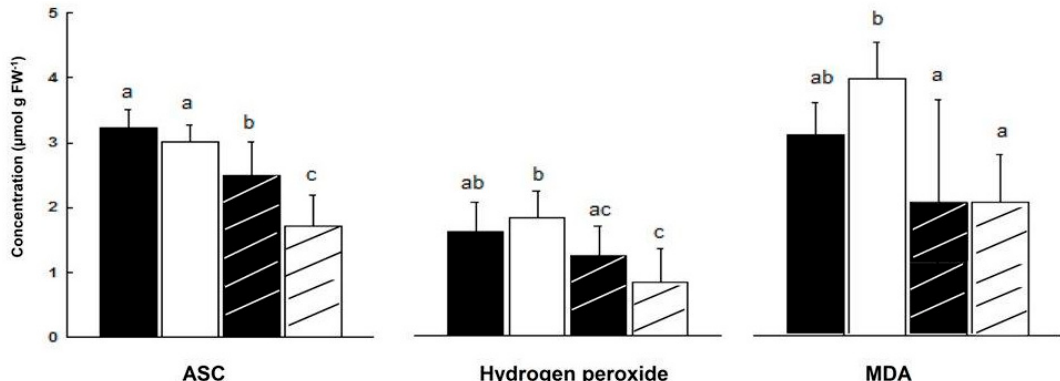
Figure 5. Effect of salinity on ASC, H 2 O 2 and MDA concentrations in leaves of ‘mature’ female and male M. annua plants. The plants were grown for 11 days in the presence or absence of NaCl (100 mM). Ave ± SD, n = 3. Different letters for a given compound indicate grouping at a significant level of p < 0.05, by Anova-Fisher’s test. —female control; —male control; —female salinity; male salinity.